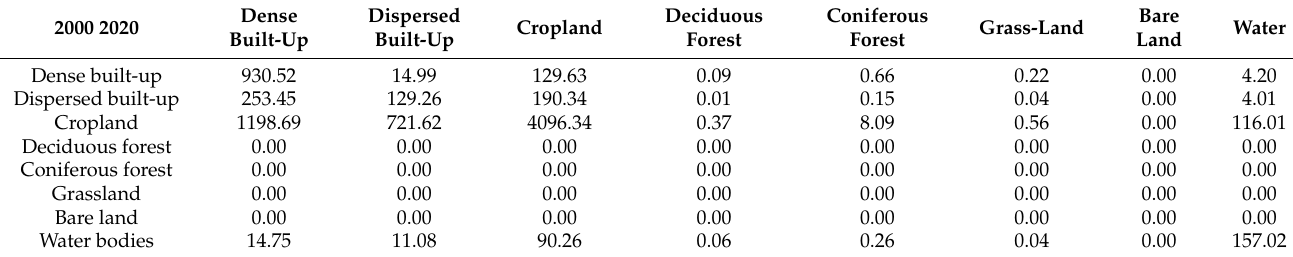
Table A6. Land cover area transfer matrix for Shanghai from 2000 to 2020 (km 2 ).